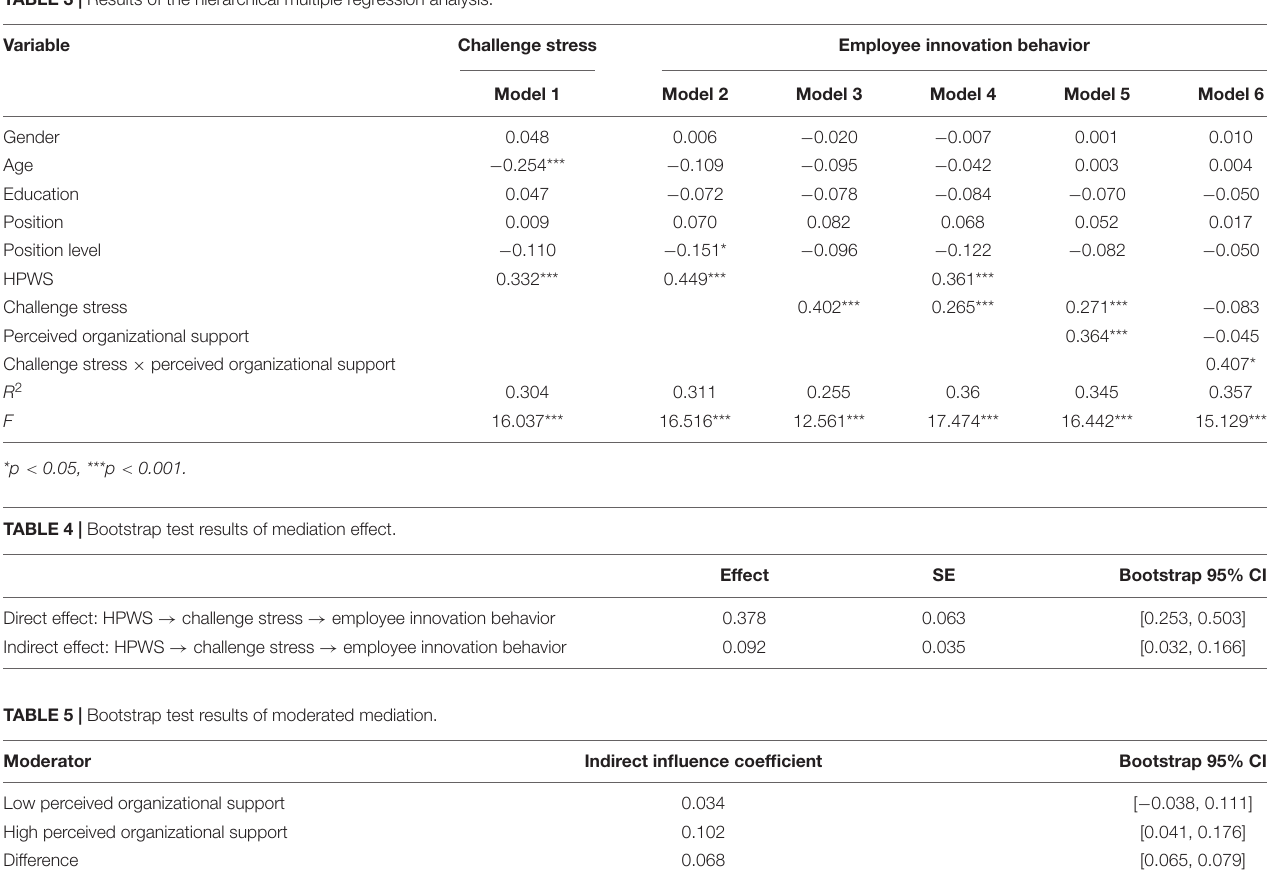
TABLE 3 | Results of the hierarchical multiple regression analysis.